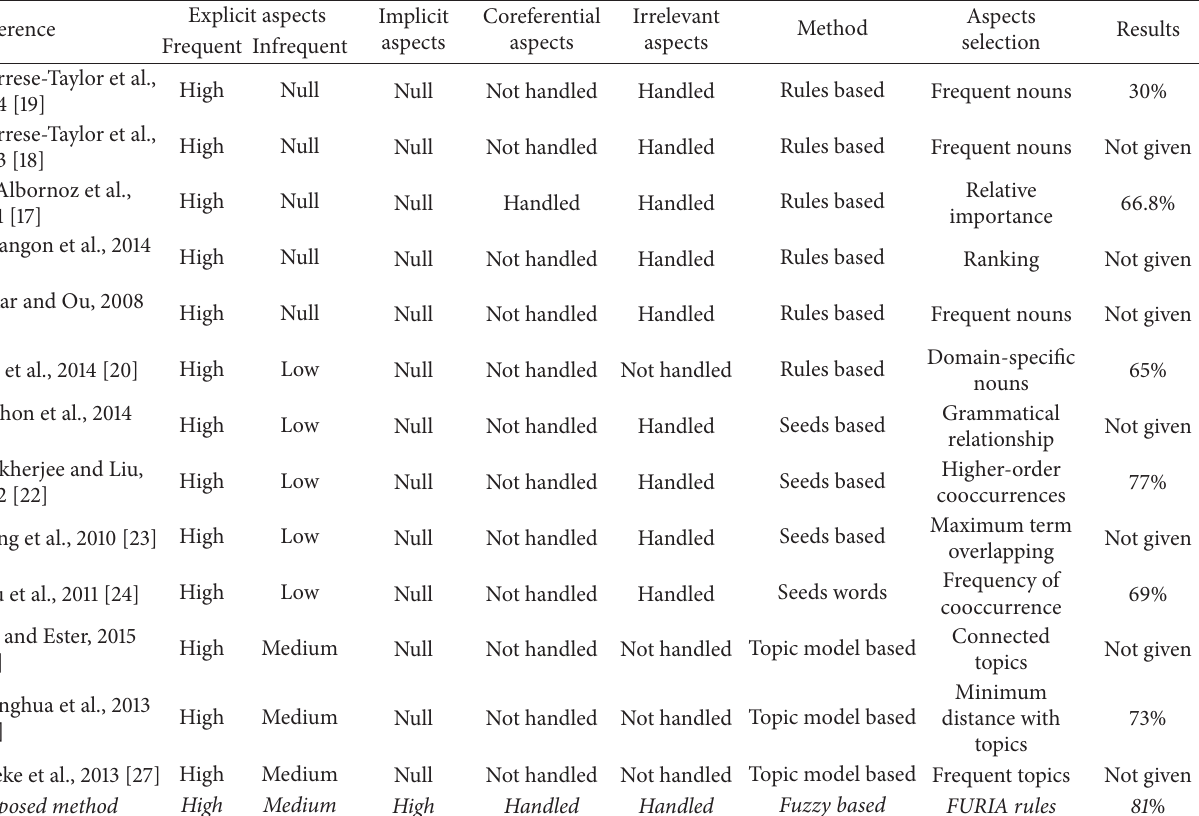
Table 1: Critical evaluation of aspects extraction